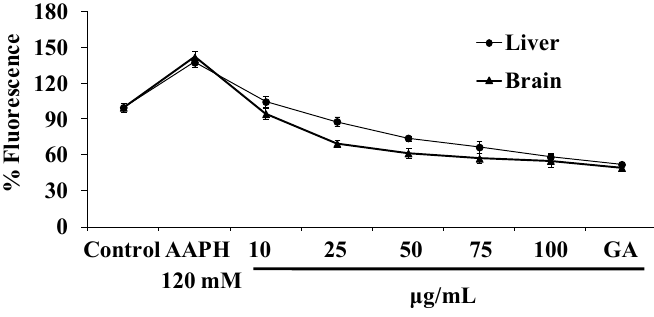
Figure 5. Antioxidant effects of NJE and gallic acid on AAPH-induced ROS